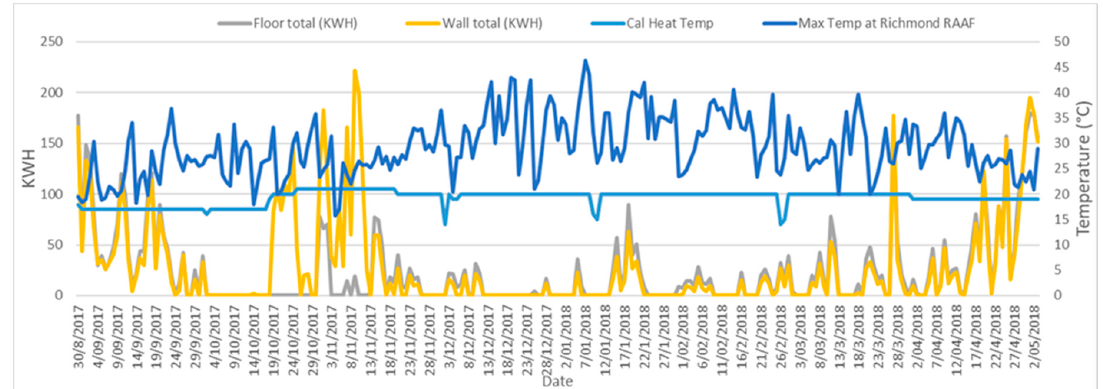
Figure 2. Active and measured temperatures and power consumption by fan and pump cooling systems over the full capsicum crop lifecycle.